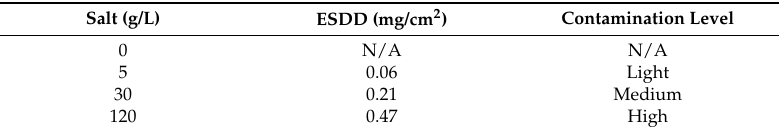
Table 3. Insulator samples’ artificial